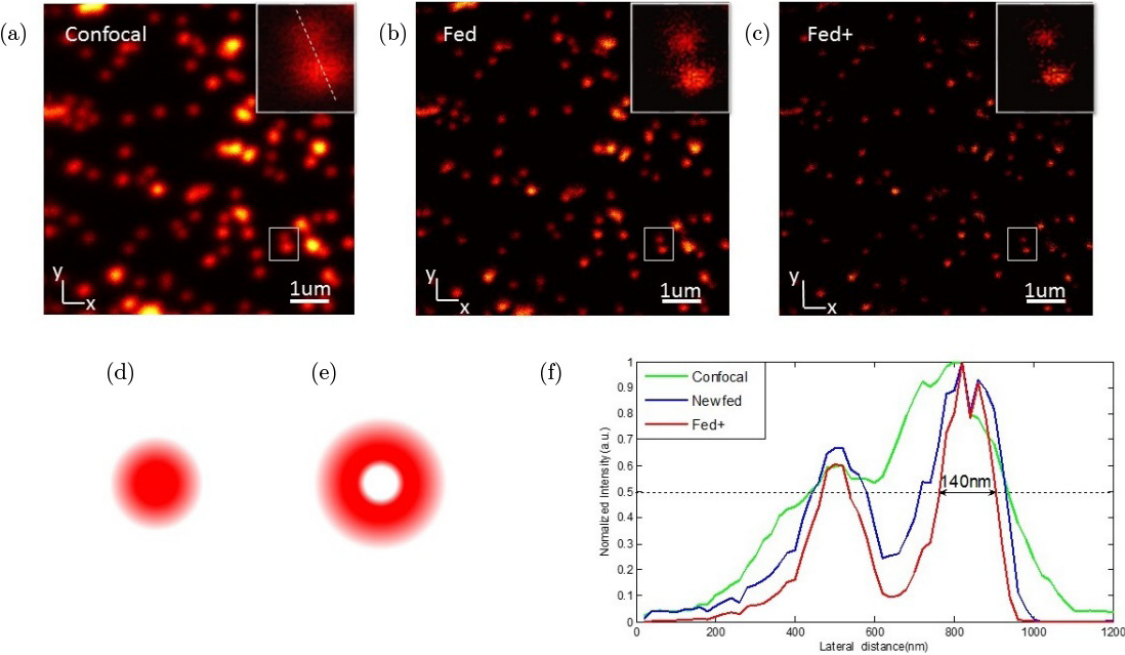
Fig. 5. 2D °uorescent nanoparticle imaging by FED and confocal methods. The ð x ; y Þ -scan size is 8 (cid:2) 8 (cid:6) m 2 ð 512 (cid:2) 512pixels) resulting in a total acquisition time of (cid:7) 5 : 24 s. (a) Confocal image. (b) The new 2D-FED image with the subtractive factor r ¼ 0 : 61. (c) Corresponding deconvoluted FED image. (d) Schematic of 2D solid spots. (e) Schematic of 2D doughnut spot. (f) Lateral intensity pro¯les along the white dashed line in a and corresponding b, c verify the resolving ability of the 2D-FED, indicating an e®ective resolution of (cid:7) 140